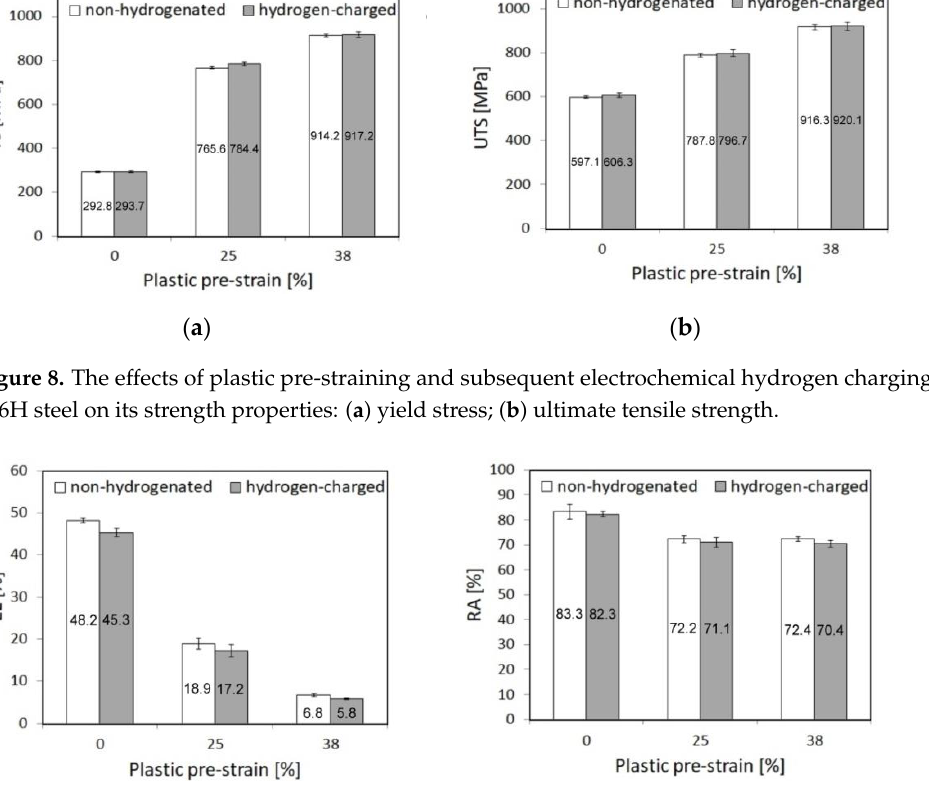
( c ) Figure 10. SEM-fractographs of fracture surfaces of broken tensile test specimens of studied 316H material in various material conditions: ( a ) as-received, non-hydrogenated; ( b ) as-received, hy- drogen-charged; ( c ) 38% plastically pre-strained, hydrogen-charged. By rule, the fracture surfaces of nonhydrogenated tensile test specimens exhibited somewhat larger pulled-out dimples, whereas the hydrogenated ones were characterized by smaller shallow dimples (Figure 10). The effect of pre-straining on the fracture sur- faces of hydrogenated specimens was also negligible. 3.3. Hydrogen Embrittlement Evaluation Quantitative estimation of the HE susceptibility of the studied material with differ- ent pre-strain levels was performed by calculation of the embrittlement index (EI) from